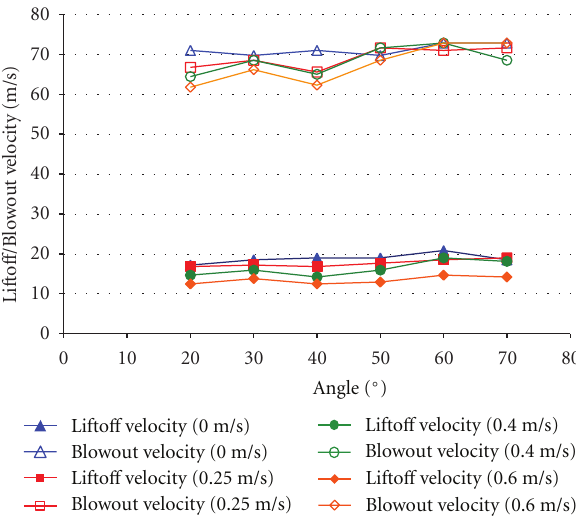
Figure 10: Stability limits versus angle including 90 ◦ and 110 ◦ .